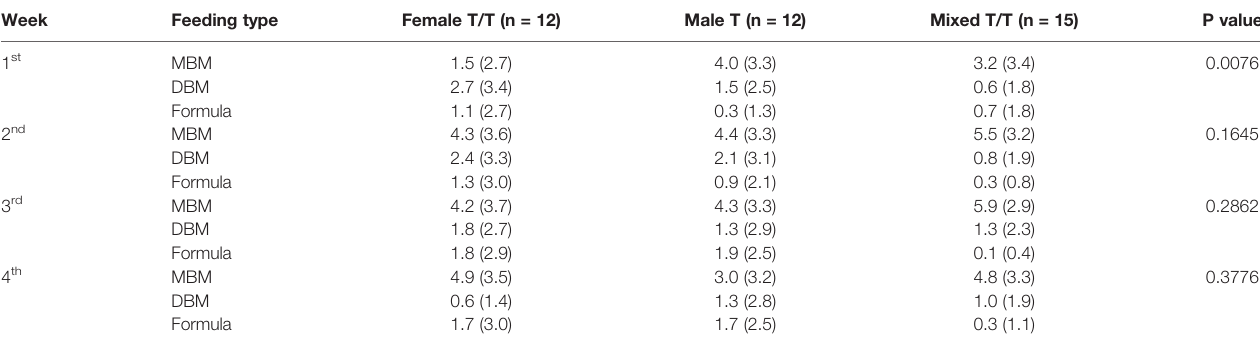
TABLE 2 | Feeding count of preterm twins/triplets (n=39) [mean (SD)]. Week Feeding